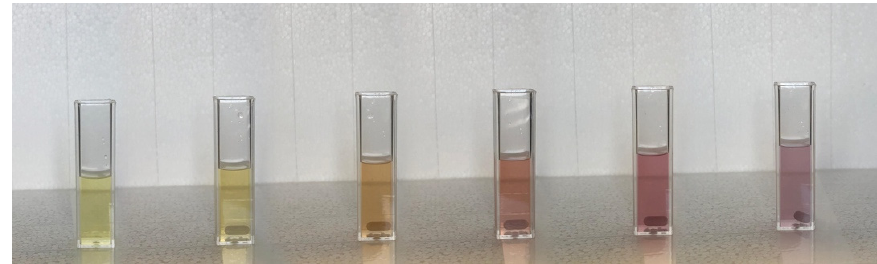
Figure 7. Color changes of AgNPs@11MUA upon addition of increasing concentration of Ni 2+ . Titration curves clearly show the occurrence of an isosbestic point at about 445 nm that splits the SPAB in two zones and supports a mechanism of direct interconversion between AgNPs@11MUA and (AgNPs@11MUA) n -(Ni 2+ ) m cluster [48]; the individual con- tribution in absorbance of the two SPABs was evaluated by deconvoluting the spectra with a lognormal equation [49–51] (Figure S1, Supplementary Materials). Titration curves were obtained by plotting the absorbance ratio at 417 and 477, respectively, as a function of Ni 2+ concentration (Figure 8).